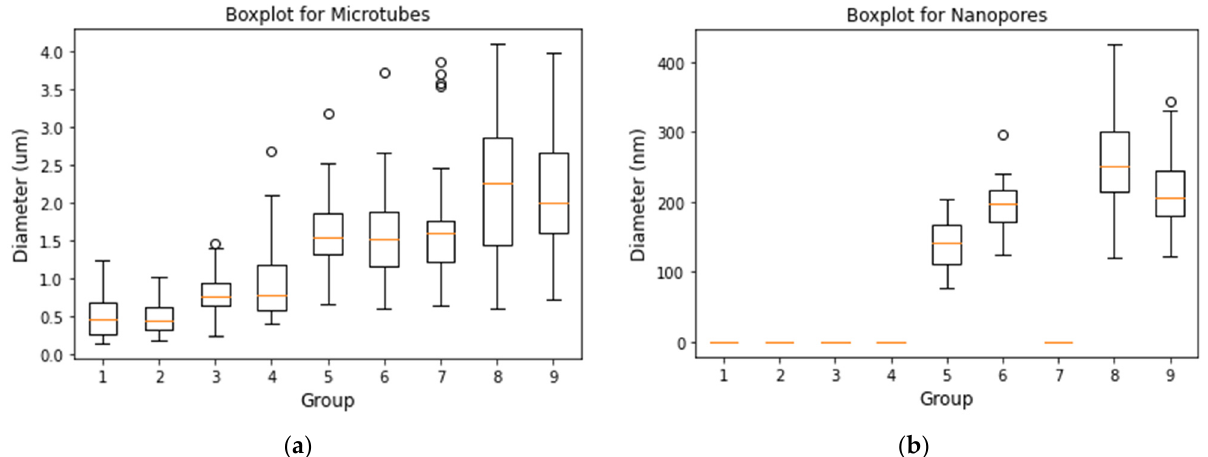
Figure 5. ( a ) Boxplot of microtubes’ and ( b ) nanopores’ diameter. Statistical analysis of microtube diameter and pore size was conducted by Minitab using a 3 × 3 design. The two factors are solution viscosity and PCL/PEO ratio in sheath solutions. The viscosity has three levels: low, middle, and high, and the ratios have three levels: 0, 3:1, and 1:1. Figure 6a shows the surface change response of microtube diameter with different viscosity and PCL/PEO ration, and Figure 6b shows the surface change response of nanopores. In these two plots, 1–3 in x axis stands for low, middle, and high three viscosity levels. 1–3 in y axis stands for 0, 3:1, and 1:1 three ratio levels. The z axis in Figure 6a shows the diameter of microtubes and the z axis in Figure 6b indicates the range of pore sizes.